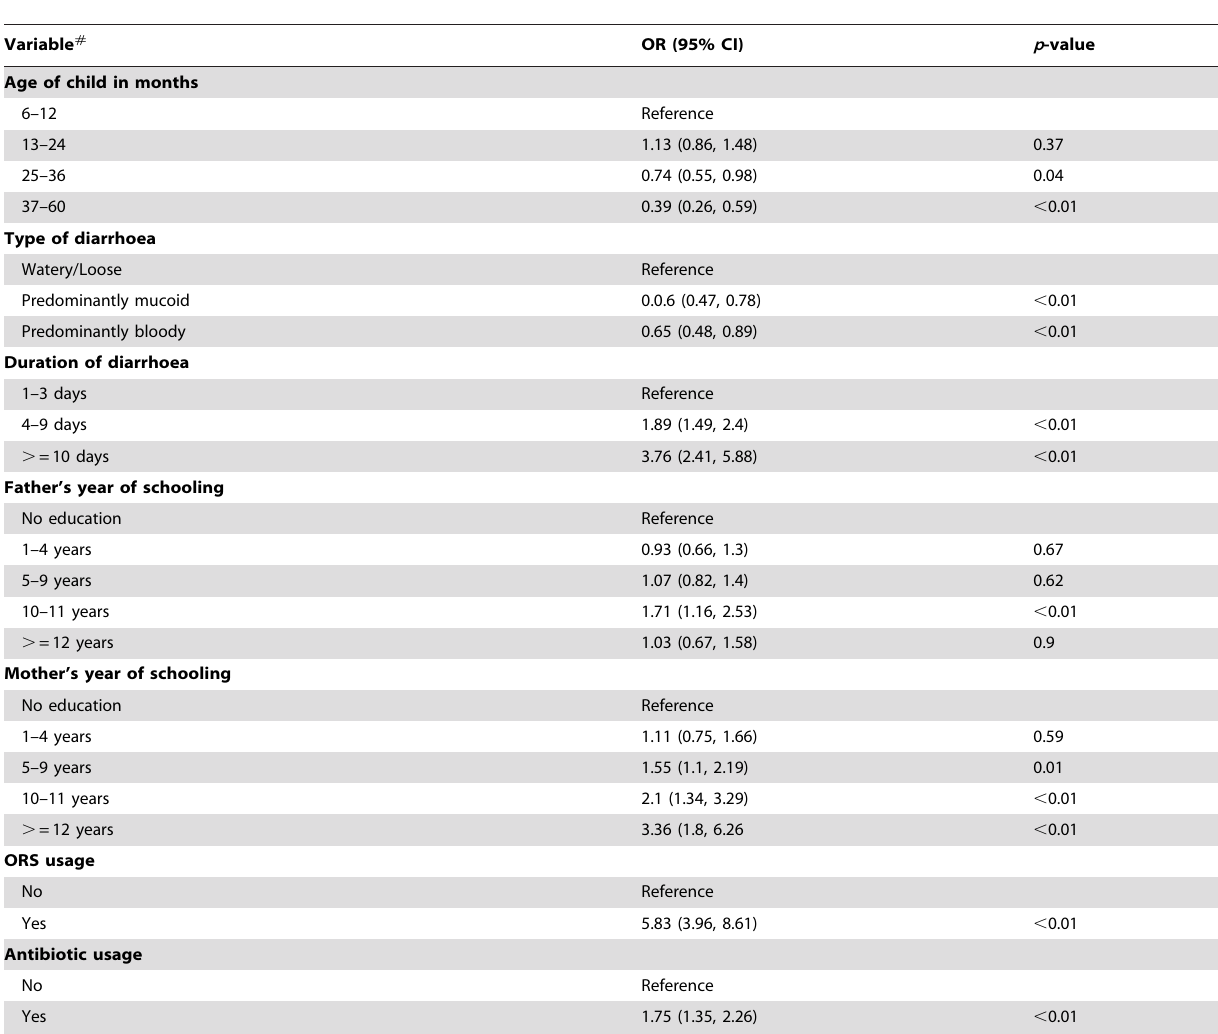
Table 4. Predictors of zinc usage in childhood diarrhoea after controlling area and time variation.